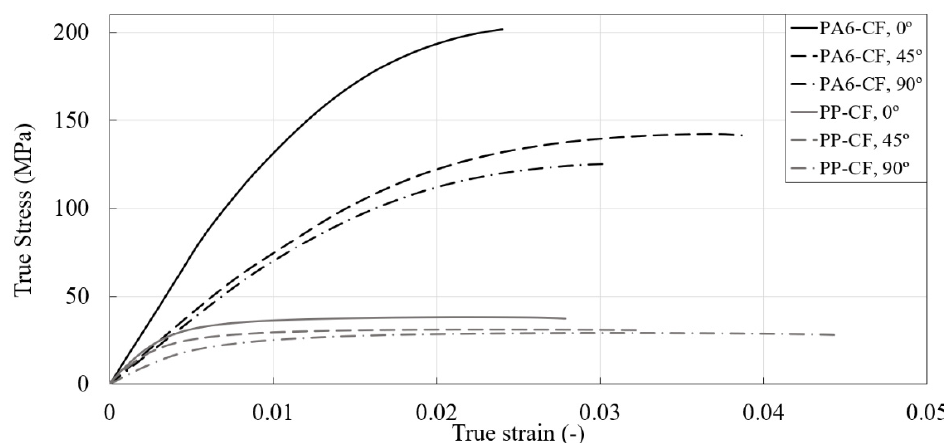
Figure 7. True stress and strain curves of the PA6-CF and PP-CF materials along 0 ◦ (injection direction), 45 ◦ , and 90 ◦ .